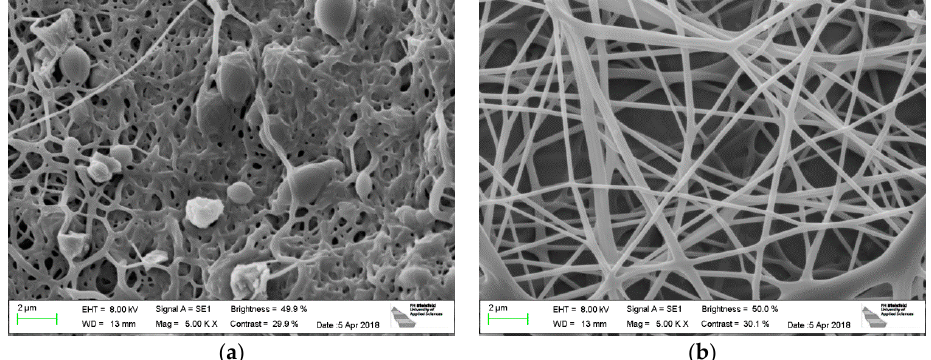
Figure 6. PAN nanofiber mats after carbonization at 500 °C: ( a ) electrospun on PP (substrate separated before stabilization); ( b ) electrospun on aluminum foil (substrate not removed before stabilization or carbonization).